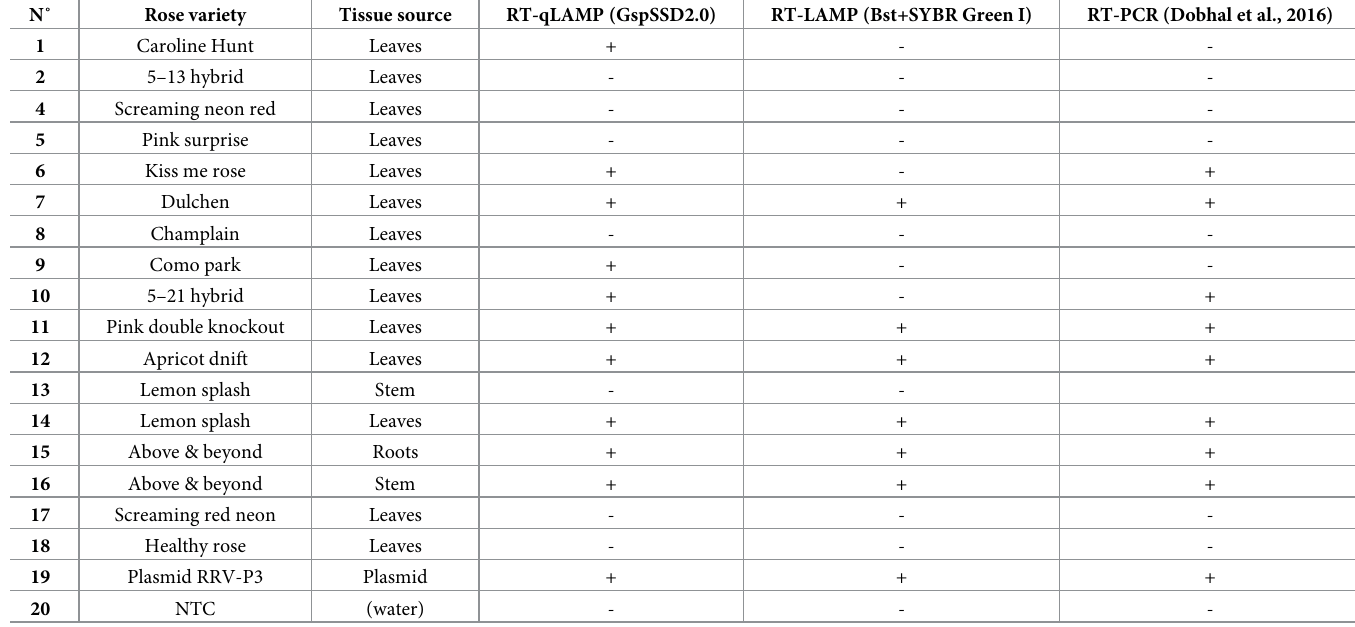
Table 4. Side-by-side comparison of RRV-P3 RT-qLAMP using GspSSD2.0, colorimetric RRV-P3 RT-LAMP using Bst 2.0, and RT-PCR.